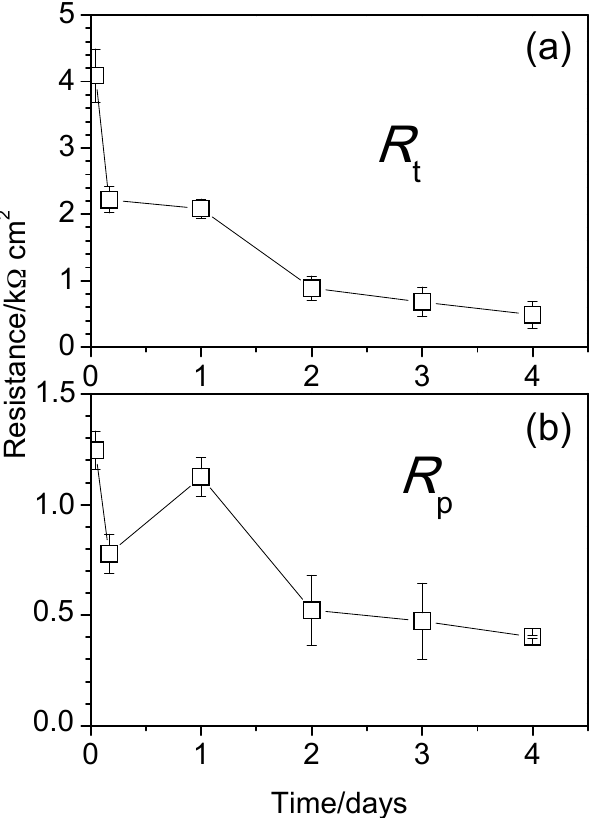
Figure 7. Variations in the resistances obtained from fitting of the EIS spectra of AZ31B, as a function of immersion time in Ringer’s solution (37 °C). Scatter bands are the standard deviation of 3 measurements.